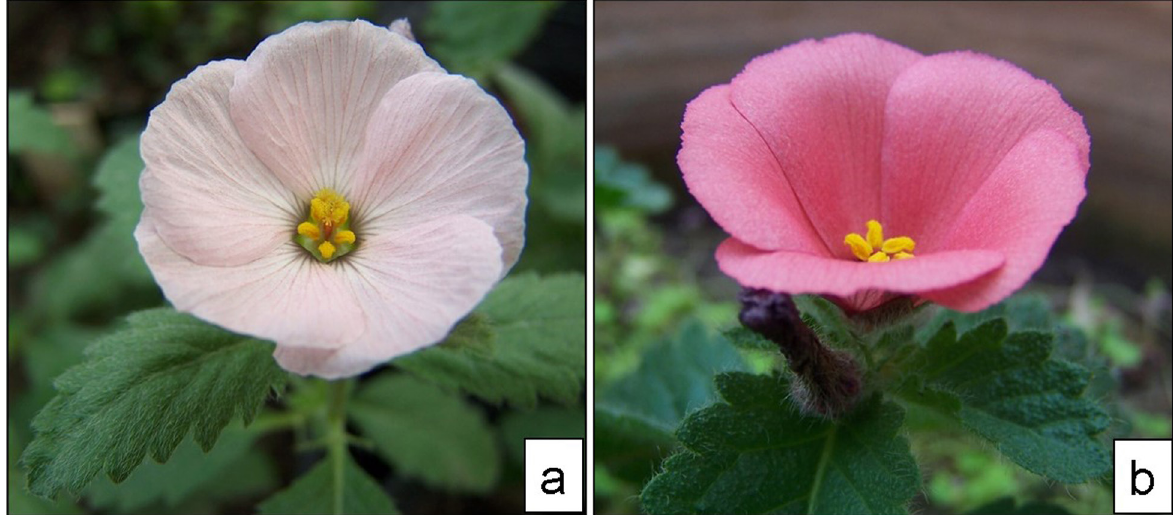
Figure 2. Blooming individuals of Turnera sidoides subsp. carnea showing the most remarkable morphological traits of the mercedeño (a) and grandense (b) morphotypes. Note the light pink petal and membranaceous leaves in (a) and the dark pink petal and coriaceous leaves in (b).